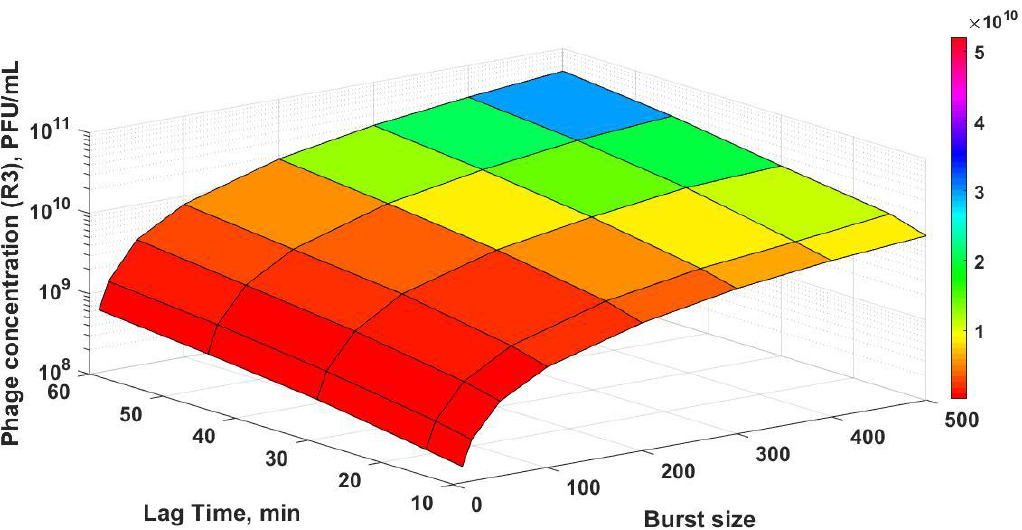
Figure 8. Surface plot showing simulation results of final phage titres in reactor R3 as a function of burst sizes [10, 20, 50, 100, 200, 300, 400, and 500] and lag times [10, 15, 30, 45, and 60] min. The other fixed simulation parameters were: C 2 = 1 × 10 10 CFU L − 1 , P 2 1 × 10 10 PFU l − 1 , S 2 = 1.5 g L − 1 , δ = 3.6 × 10 − 9 L hr − 1 , and the semi-batch reactor inlet flow rate used was 0.25 L hr − 1 .